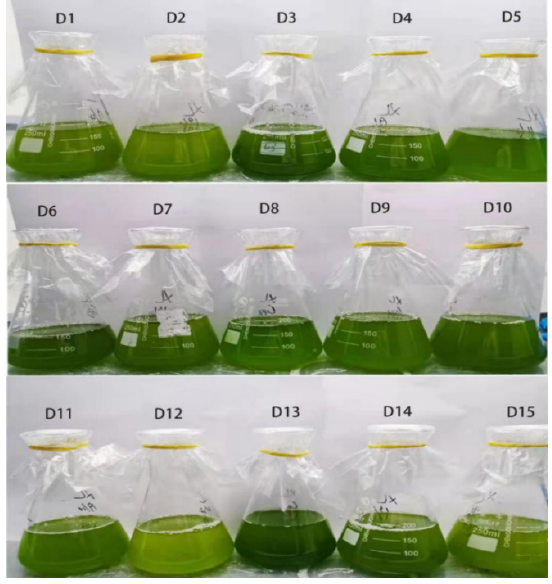
Figure 1. Appearance of the 15 Dunaliella species in Erlenmeyer flasks after 40 days of culture.